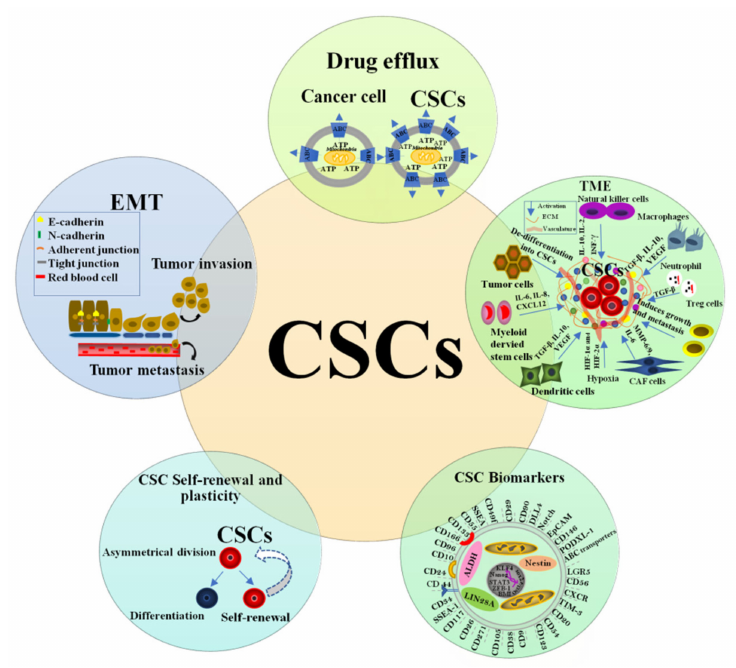
Figure 3. The defining properties